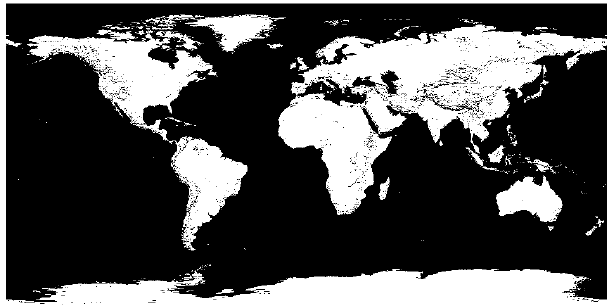
Figure 15. Global topographic shadow mask (TSM).